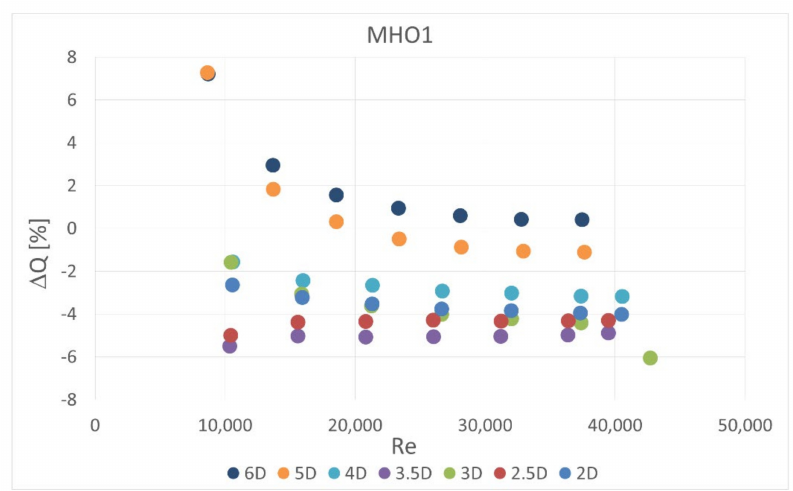
Figure 16. Measurement error of mass flow rate in SHO1 for disturbed flow.